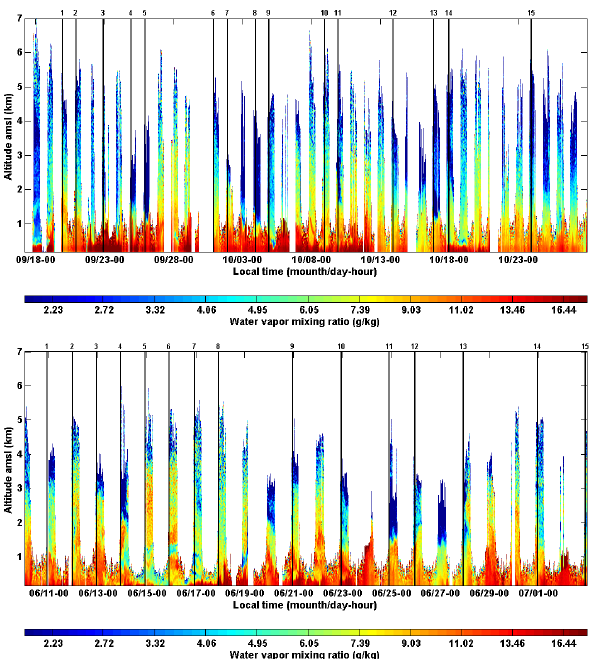
Figure 1. Time localization of the IASI profiles used for the inter- comparisons (vertical black lines identified with the CN at the top) with respect to the temporal WALI lidar WVMR (in gkg − 1 ) re- trieval evolution as a function of altitude (in km) during the HyMeX (up) and ChArMEx (down) periods. Lidar profiles are given with a high temporal resolution of 5min averaging. The color bar ranges from low water vapor mixing-ratio (blue) to high ones (red).